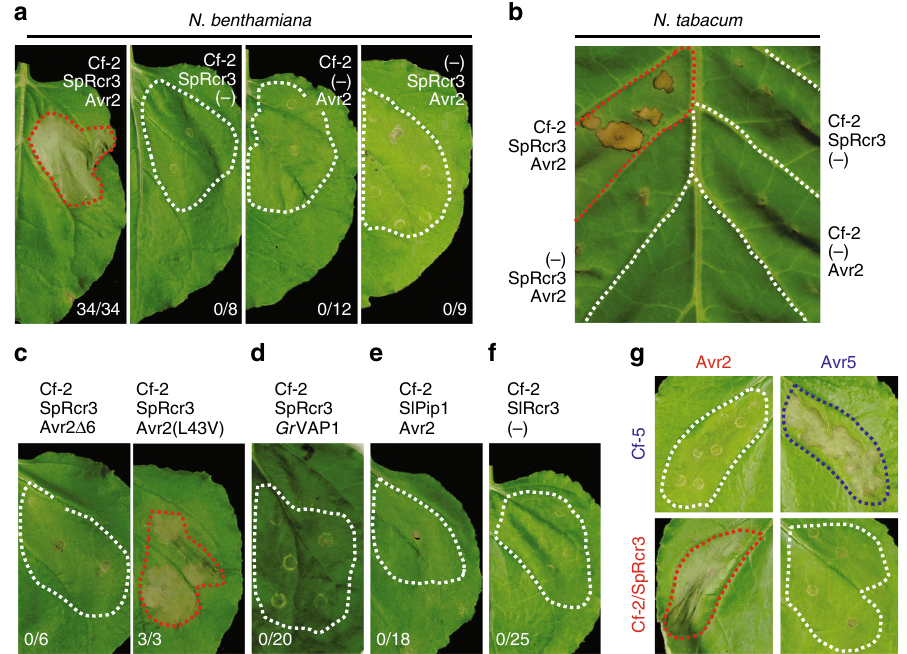
Fig. 1 Transient co-expression of Rcr3 with Cf-2 and Avr2 triggers HR. a Co-expression of Cf-2, Sp Rcr3, and Avr2 triggers a HR in N. benthamiana . Agrobacterium containing binary vectors for the expression of Sp Rcr3, Avr2 and a codon-optimized Cf-2 were in fi ltrated in fully expanded N. benthamiana leaves. Omitting one of the three components results in a loss of HR. b Co-expression of Sp Rcr3 with Cf-2 and Avr2 triggers HR in tobacco. Sp Rcr3, Cf-2, and Avr2 were expressed in N. tabacum cv. Petite Havana SR1 by agroin fi ltration without the P19 silencing inhibitor. c HR is triggered by Avr2(L43V) but not by Avr2 Δ 6. Sp Rcr3, and Cf-2 were co-expressed with either an Avr2 mutant (Avr2 Δ 6) or with a natural variant of Avr2 containing the L43V substitution. d Transient co-expression of nematode effector Gr VAP1 with Sp Rcr3 and Cf-2 does not trigger a HR. e Sl Pip1 does not trigger HR when co-expressed with Cf-2 and Avr2. f The auto-necrosis-inducing S. lycopersicum allele of Rcr3 ( Sl Rcr3) does not trigger a HR when co-expressed with Cf-2 in the absence